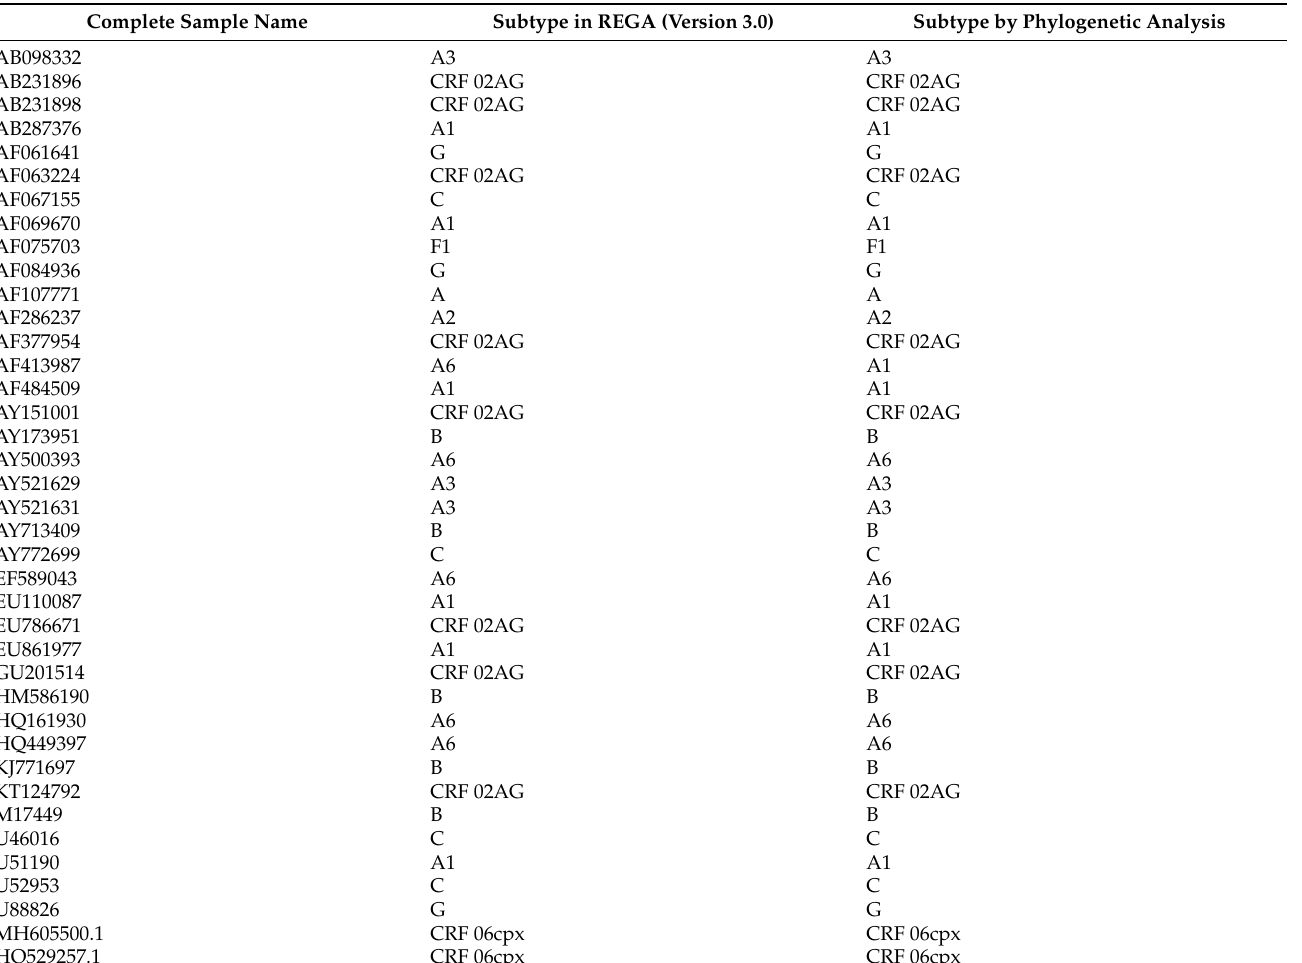
Table A1. Complete sample names of reference